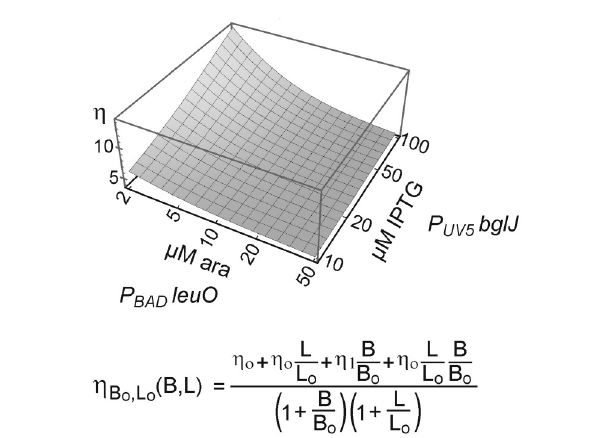
FIGURE 6 | Modeling of antagonistic regulation of leuO transcription by BglJ-RcsB and LeuO. To describe the transcription rate directed by P leuO in dependence of the concentration of BglJ and LeuO, a thermodynamic model based on Michaelis-Menten kinetics was used. In this model it was assumed that BglJ and LeuO bind and regulate leuO transcription independently of each other. Median fluorescence values of flow cytometry data ( Figure 5 ) were fitted to the function (bottom) describing leuO promoter activity in dependence of promoter occupancy by BglJ and LeuO. Fitting of the parameters to the experimental data by nonlinear regression according to ( Fox and Weisberg, 2011) yielded P -values < 0.001. The data were plotted with Mathematica (Wolfram Research) using logarithmic scales for induction of plasmidic leuO with arabinose (ara) and of plasmidic bglJ with IPTG.